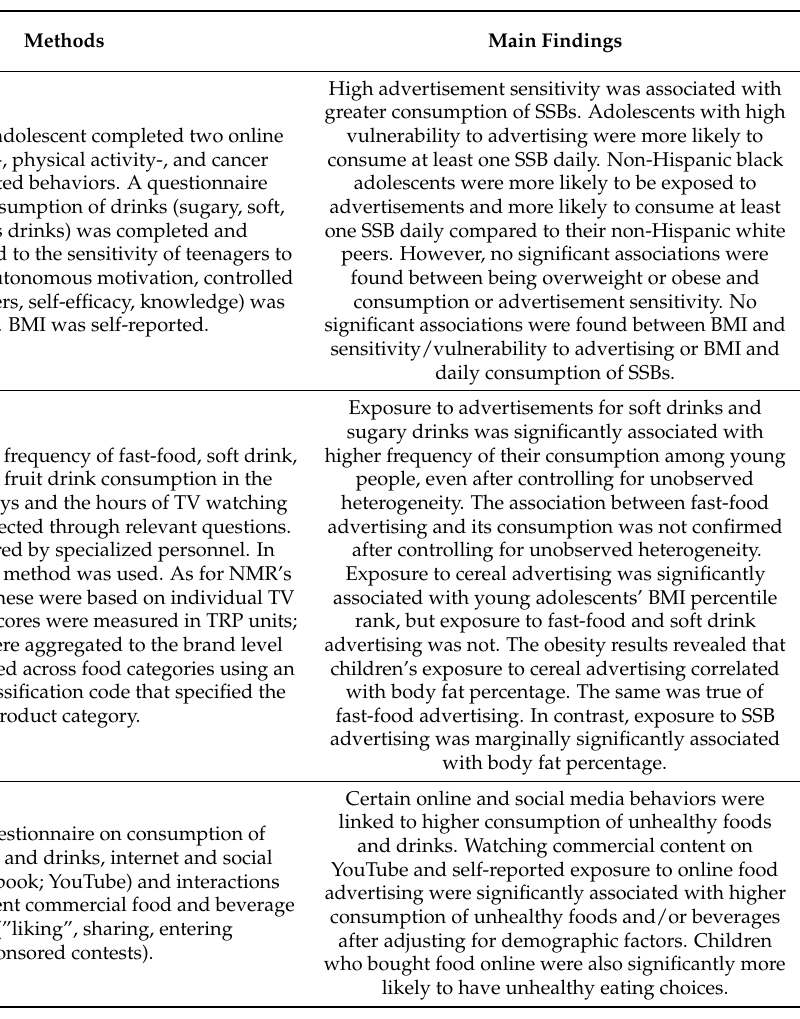
Table 1. Results of studies examining the association between nutrition-related messages through advertising, video games, and social media and nutritional choices and obesity/overweight/body fat in